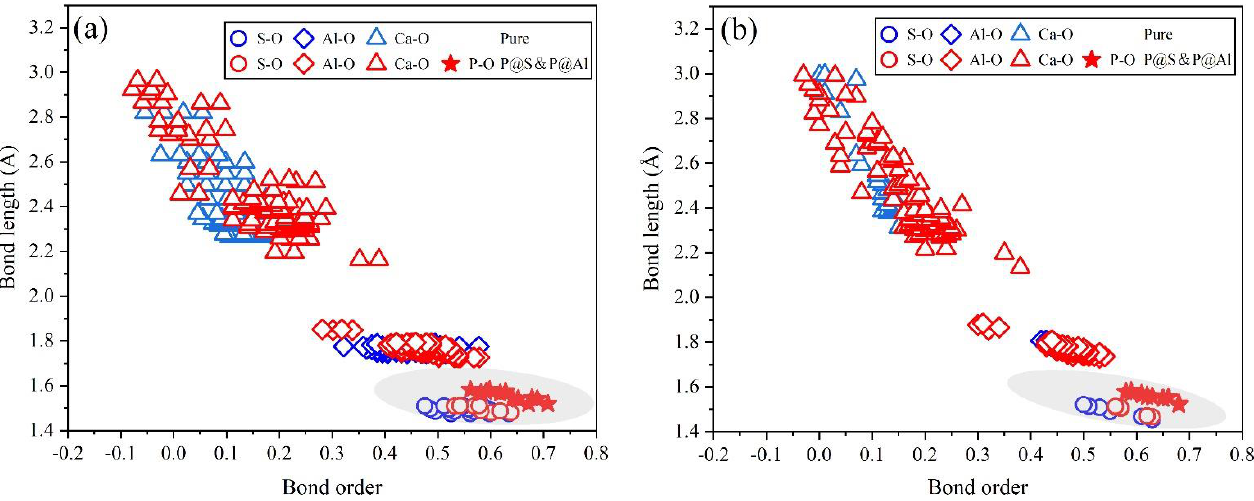
Figure A2. Distributions of BL – BO in pure and the most probably P- doped ye’elimite: ( a ) P@S ＆ P@Al(ST) and ( b ) P@S ＆ P@Al(SS).